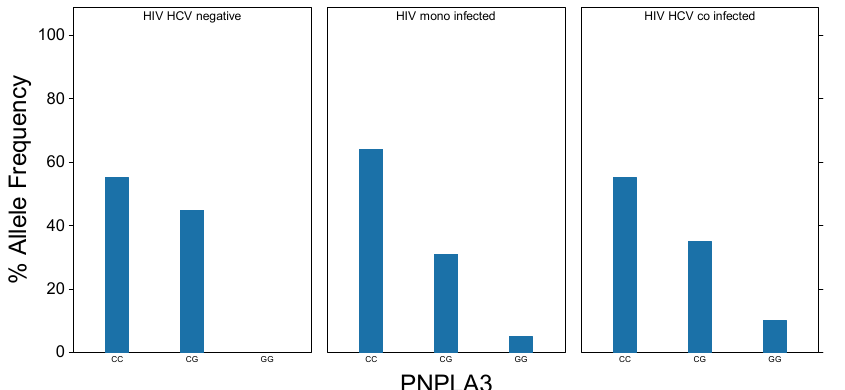
Figure 1. Gene frequency of PNPLA3 alleles by group.